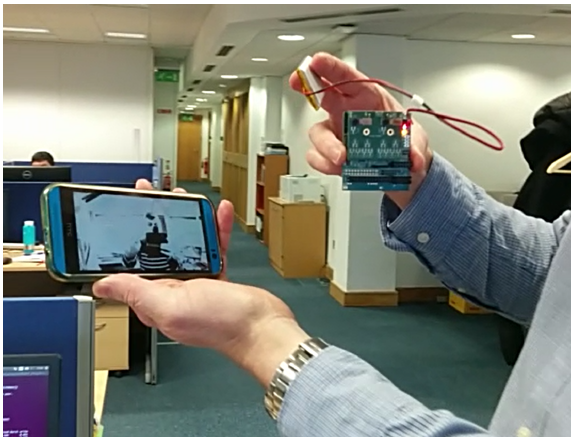
Figure 12. Battery-operated EoT streaming video to an Android smartphone.